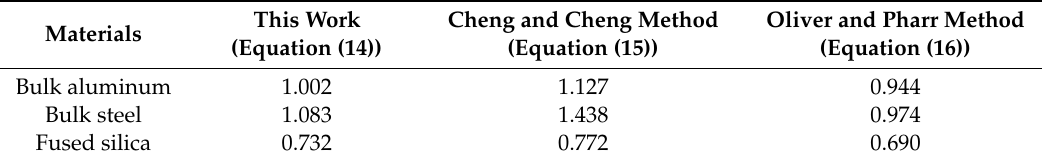
Table 1. Contact depth h c / h m ratio comparison.